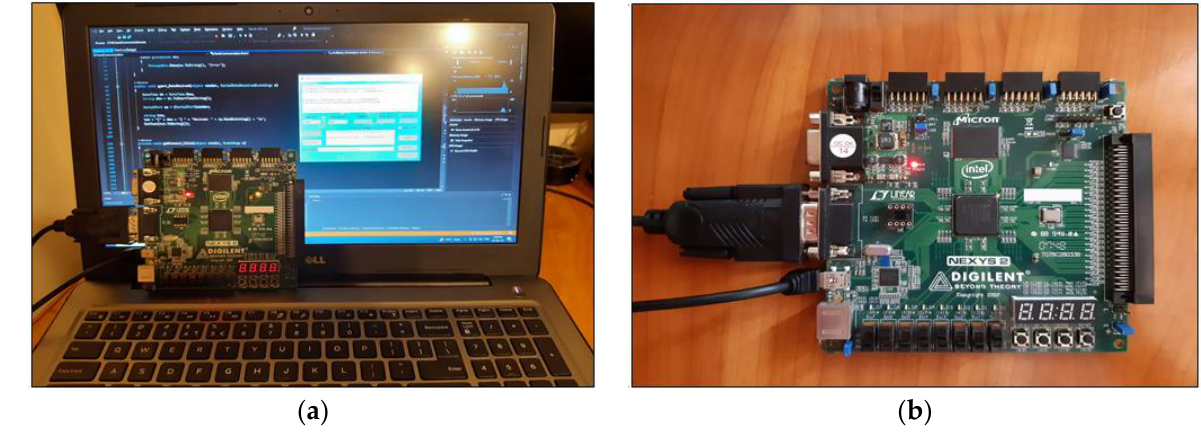
Figure 11. ( a ) Entire cryptosystem; ( b ) FPGA board.